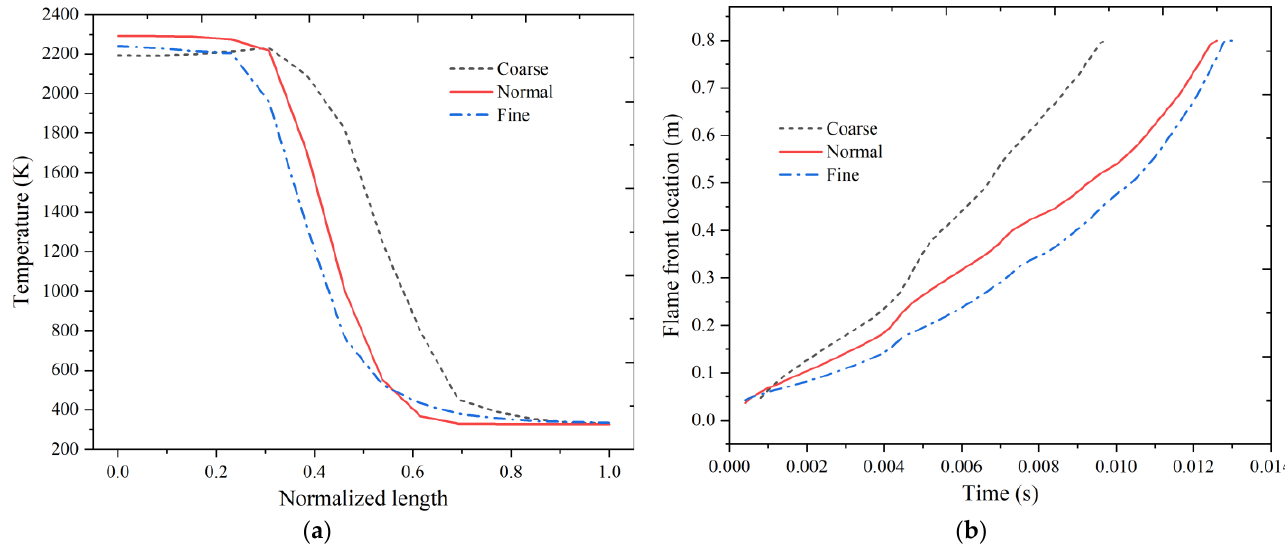
Figure 2. Results of the flame propagation for the three grids: ( a ) temperature along the thickness direction of the flame front; ( b ) flame front position as a function of time.